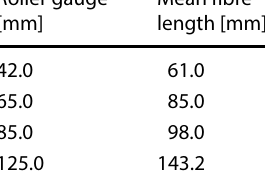
Table 5 Influence of the roller gauge of the stretch breaking unit on the mean fibre length of metal staple fibre